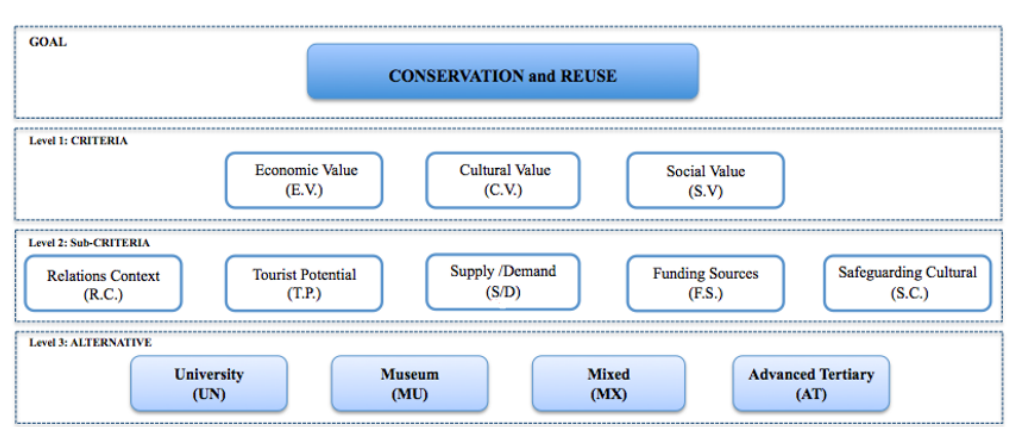
Figure 2. Hierarchical decisional scheme: Objective – Criteria – Sub-criteria – Alternatives The Economic Value (E.V.) is expressed by the monetary benefits resulting from the asset or rather the benefits it should return (in terms of opportunity cost) (Calabr`o & Spina,